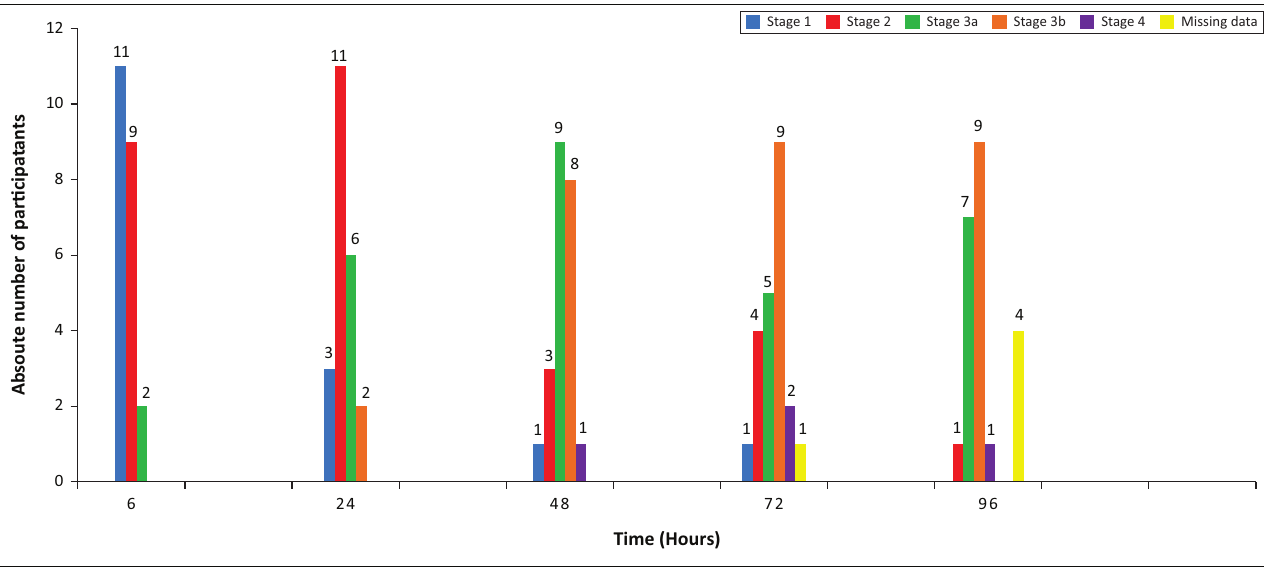
FIGURE 6: The number of participants classified per renal stage at each time interval using the serum creatinine results obtained from the kinetic Jaffe method to calculate estimated glomerular filtration rate using the Chronic Kidney Disease-Epidemiology equation. Blue bars = stage 1 (eGFR ≥ 90 mL/min per 1.73 m²), Red bars = stage 2 (eGFR 60 mL/min per 1.73 m² – 89 mL/min per 1.73 m²), Green bars = stage 3a (eGFR 45 mL/min per 1.73 m² – 59 mL/min per 1.73 m²), Orange bars = stage 3b (eGFR 30 mL/min per 1.73 m² – 44 mL/min per 1.73 m²), Purple bars = stage 4 (15 eGFR mL/min per 1.73 m²– 29 eGFR mL/min per 1.73 m²), Missing data due to haemolysis or insufficient sample = yellow